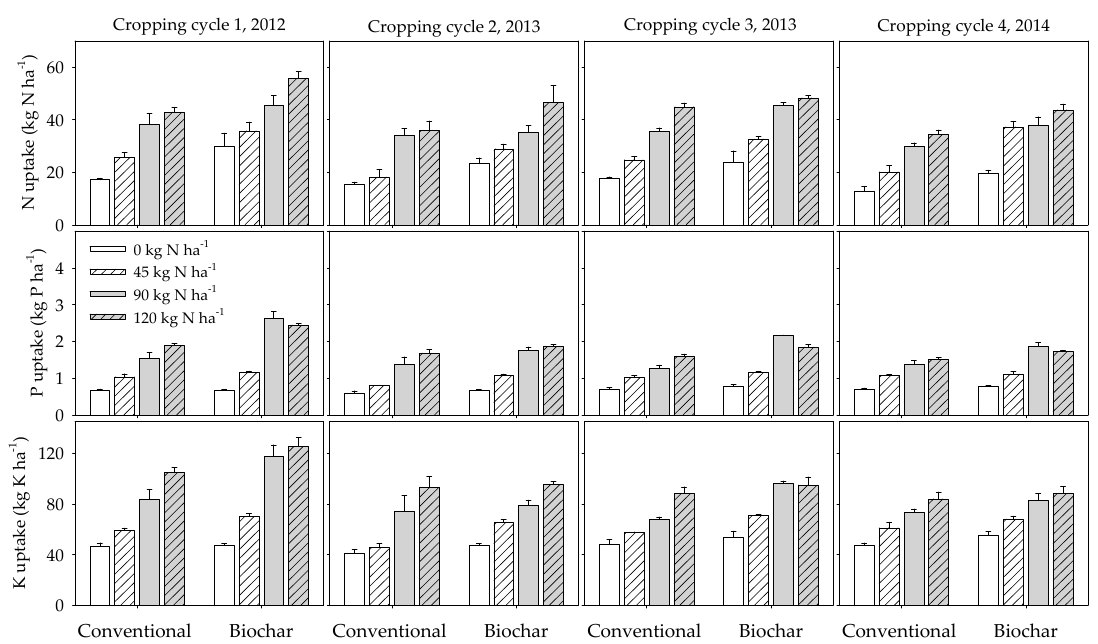
Figure 3. Effect of biochar (10 t·ha − 1 ) and nitrogen fertilizer (kg·ha − 1 ) on the nutrient uptake in rice straw under irrigated conditions over 4 cropping cycles at Kpong Ghana. Error bars are standard deviations of the means. The 1st and 3rd cropping cycles were from July to November while the 2nd and 4th cropping cycles spanned the period December to April.